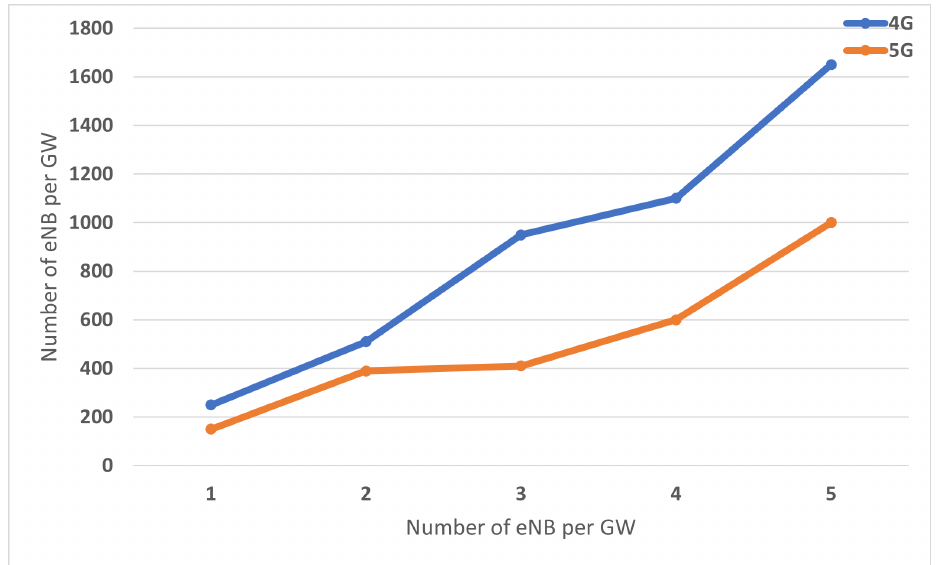
Figure 16. Comparison of 4G and proposed 5G in terms of latency of Intra-Handover with eNB per Gateway.